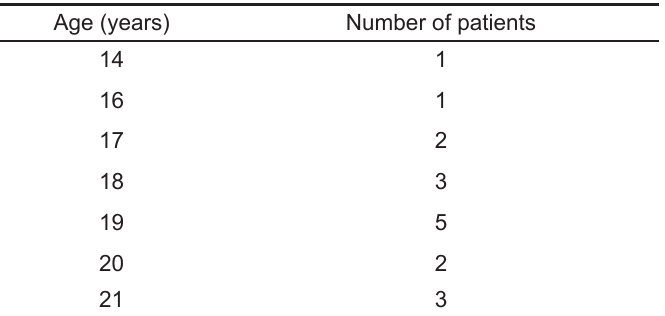
Table 1. Deaths by reported age.